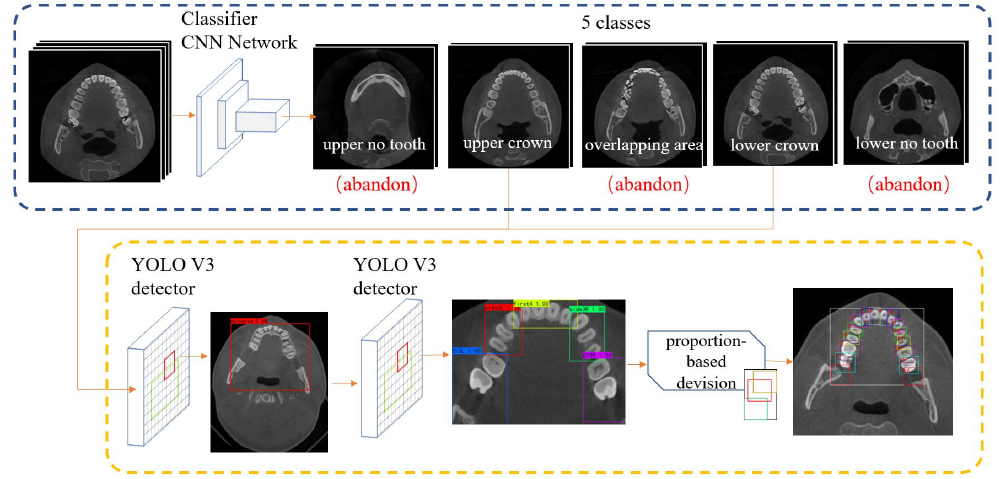
Figure 2. Whole detection network. In the pre-processing part on the left, the input CBCT images are divided into 5 layer classes. Selected images from 2 layers are input into detection part. After multi- scale detection and proportion-based division we get tooth bounding